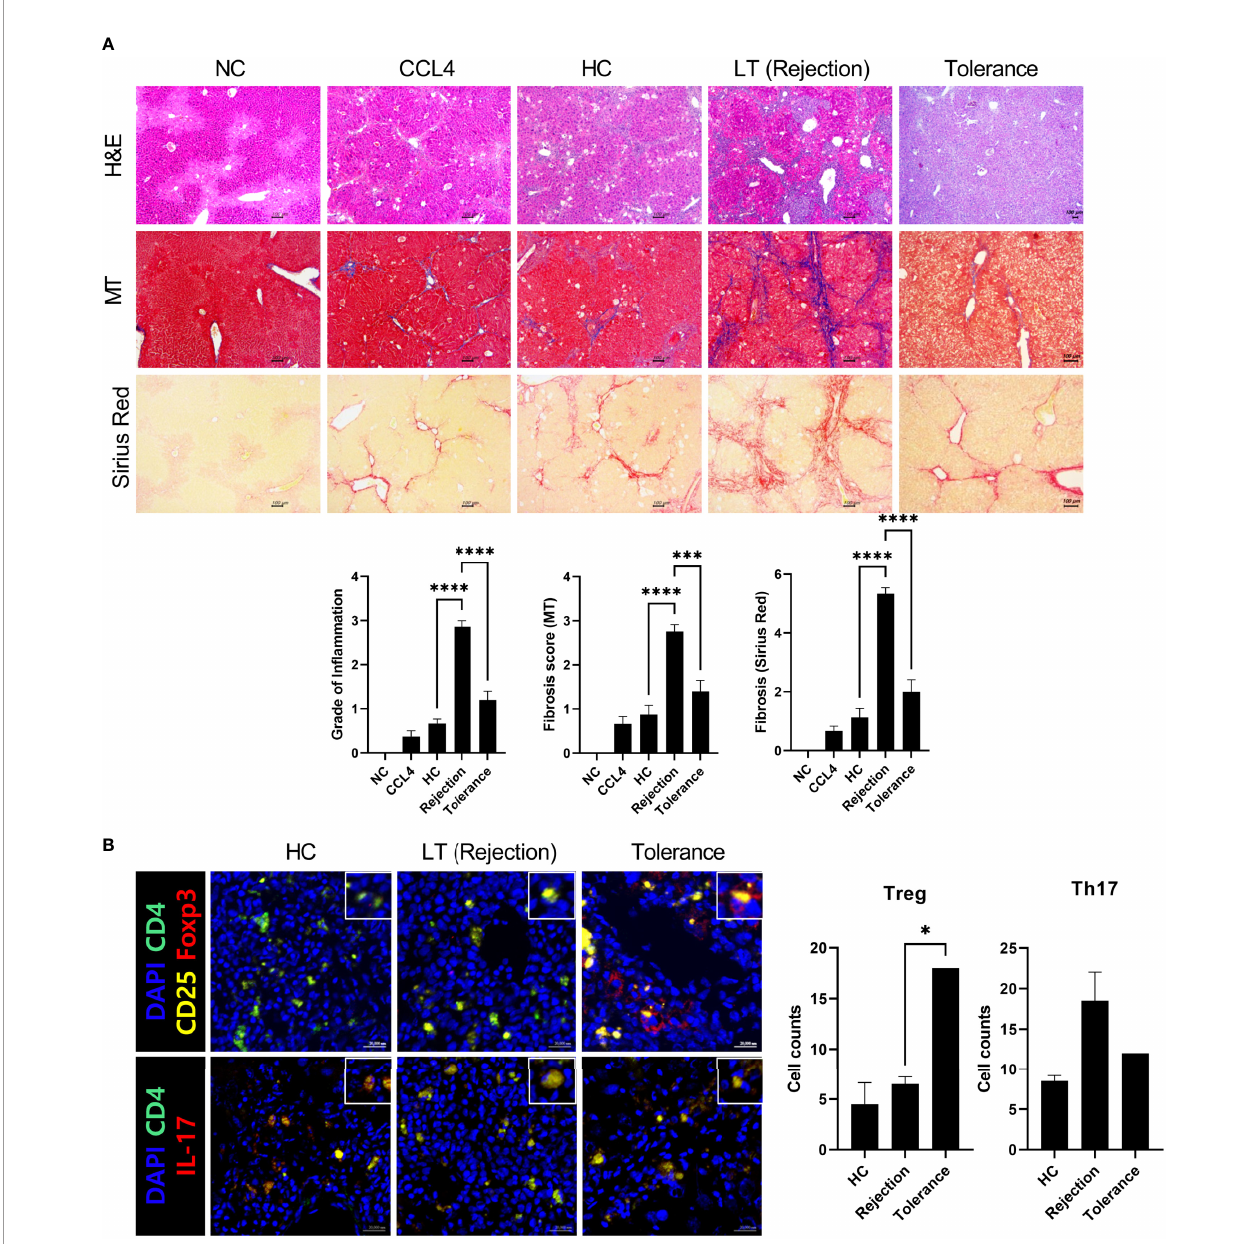
FIGURE 5 | Histologic evaluation of patient-derived avatar models generated from tolerant patients. (A) Representative liver histology of avatar models from HC, rejection, and tolerant patients. Liver tissue sections were harvested from humanized mice at 7 weeks after adoptive transfer with PBMC preparations from HC or LT patients (rejection and tolerance) and stained with H&E, MT, and Sirius red in paraf fi n-embedded avatar model (upper panel). In fl ammation and fi brosis scores are shown in the lower panel. (B) Representative confocal microscopic analysis for Treg and Th17 cell localization in liver tissues. Cells were stained with fl uorescence- tagged antibodies to determine the counts of CD4 + CD25 + Fox3 + (Treg) and CD4 + IL-17 + (Th17) cells in liver tissue sections (×100, original magni fi cation). NC, negative control; HC, healthy control; PBMC, peripheral blood mononuclear cell; LT, liver transplantation; H&E, hematoxylin and eosin; MT, Masson ’ s trichrome. * P < 0.05; *** P < 0.001; **** P <